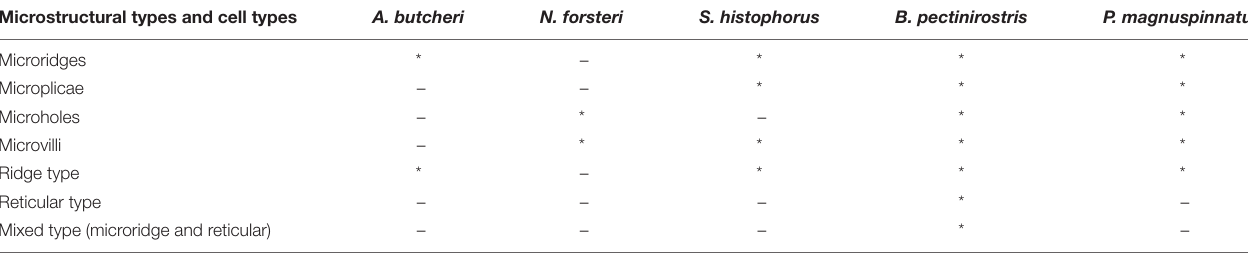
TABLE 1 | Corneal epithelial cell microstructure and type comparison among different species and mudskippers.